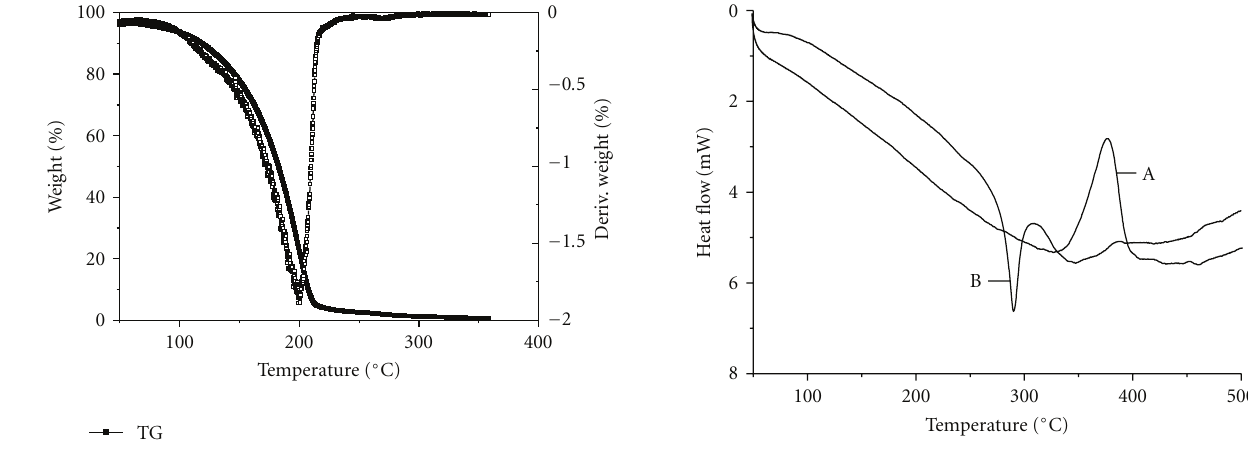
Figure 5: DTA curves of the untreated (A) and treated cotton